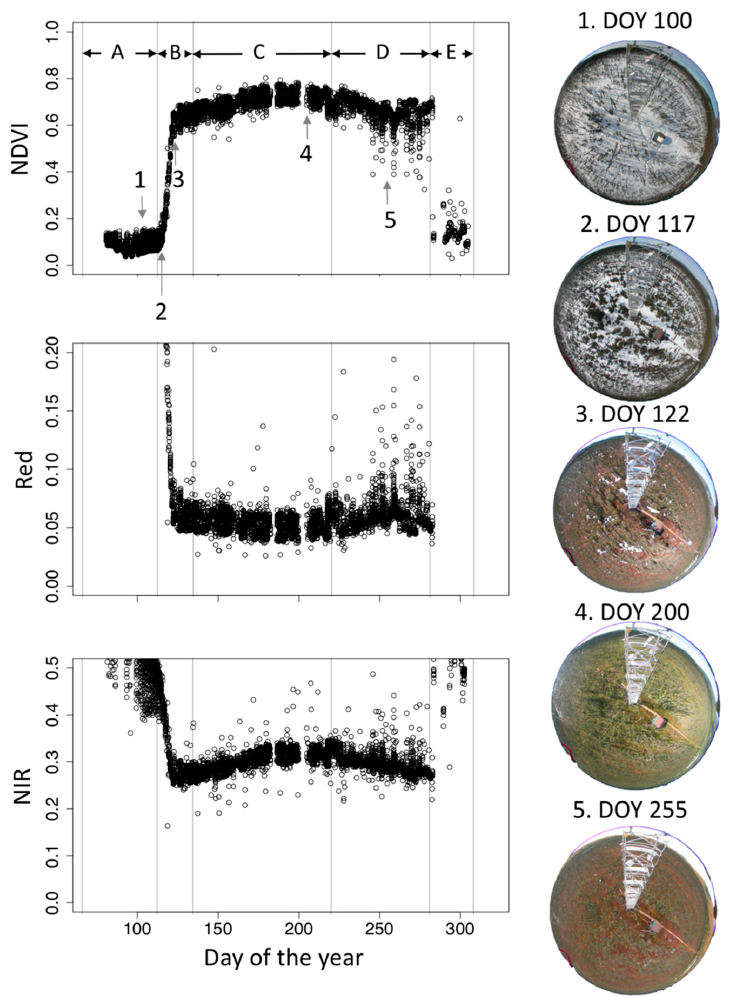
Figure 2. Seasonal variations in canopy scale normalized difference vegetation index (NDVI), and reflectances in Red and NIR in 2017. All quality-controlled data are shown. A–E indicates the division of phenological stages analyzed in this study. Stage A: Day of the year (DOY) 80–110, stage B: DOY 111–125, stage C: DOY 126–220, stage D: 221–282, and stage E: DOY 283–304. Hemispherical images on the typical phenological timings are also shown in the right side. Vertical dotted gray lines are the date of the time lapse camera images (1: DOY 100, 2: DOY 117, 3: DOY 122, 4: DOY 200, and 5: DOY255).